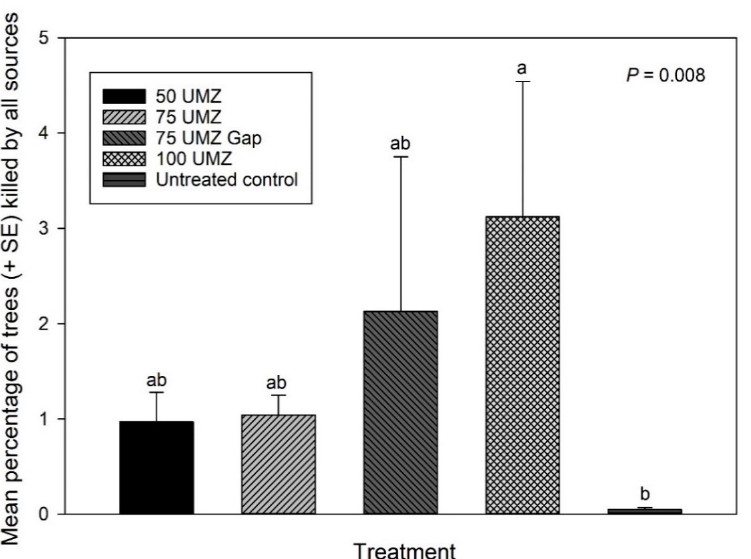
Figure 1. Mean percentage (+SE) of trees killed by all causes following thinning and prescribed burning at Pringle Falls Experimental Forest, Oregon. Means (+SE) followed by the same letter are not significantly different ( p > 0.05).